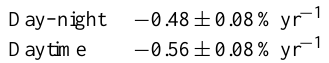
Table 2. Linear trend of Aura ClO convolved with Mauna Kea av- eraging kernels ∗ .